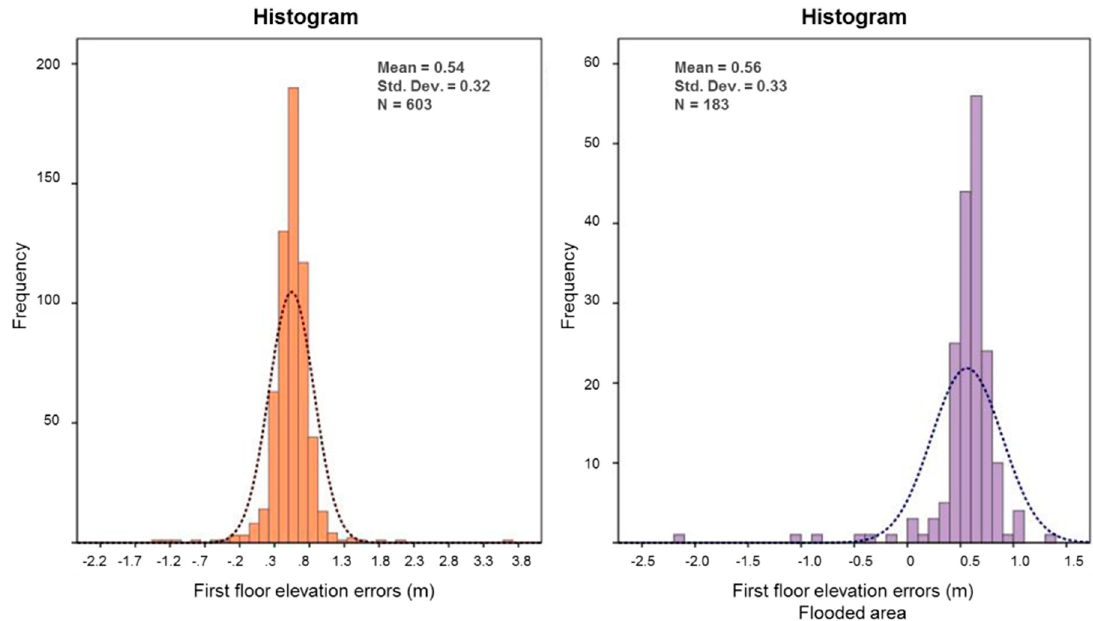
Figure 3. Histograms of first floor elevation errors for both the whole study are and the 500-year flood zone.